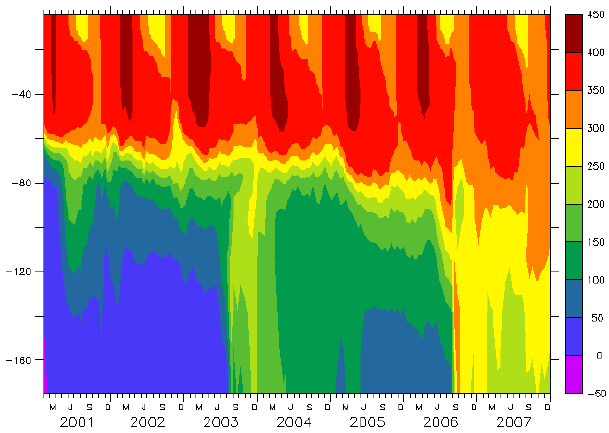
Fig. 5. Temporal evolution of the profile of dissolved oxygen at Station 213, unit: mmolm − 3